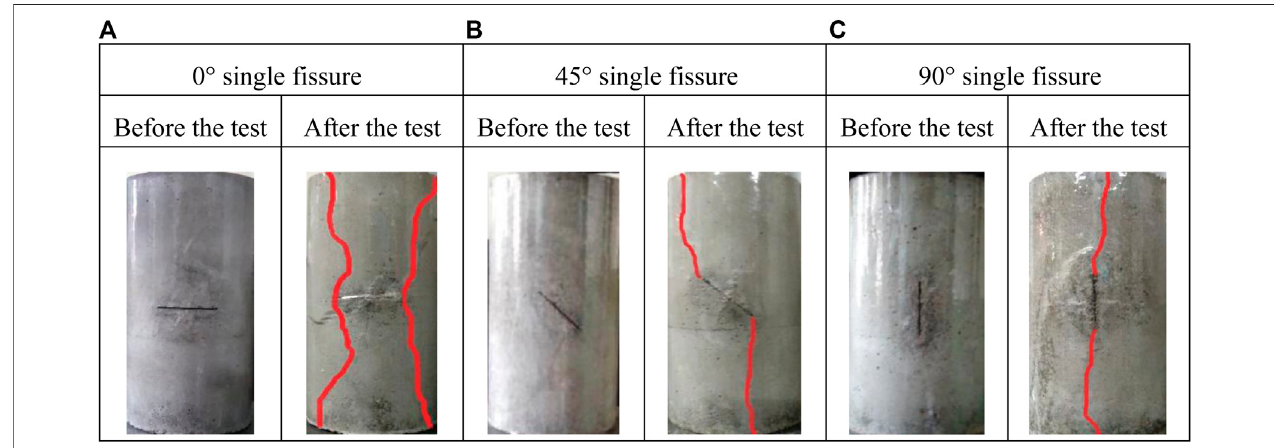
FIGURE 13 | Failure mode of the cracked samples for (A) 0 ° single fi ssure sample, (B) 45 ° fi ssure crack sample, (C) 90 ° single fi ssure sample.